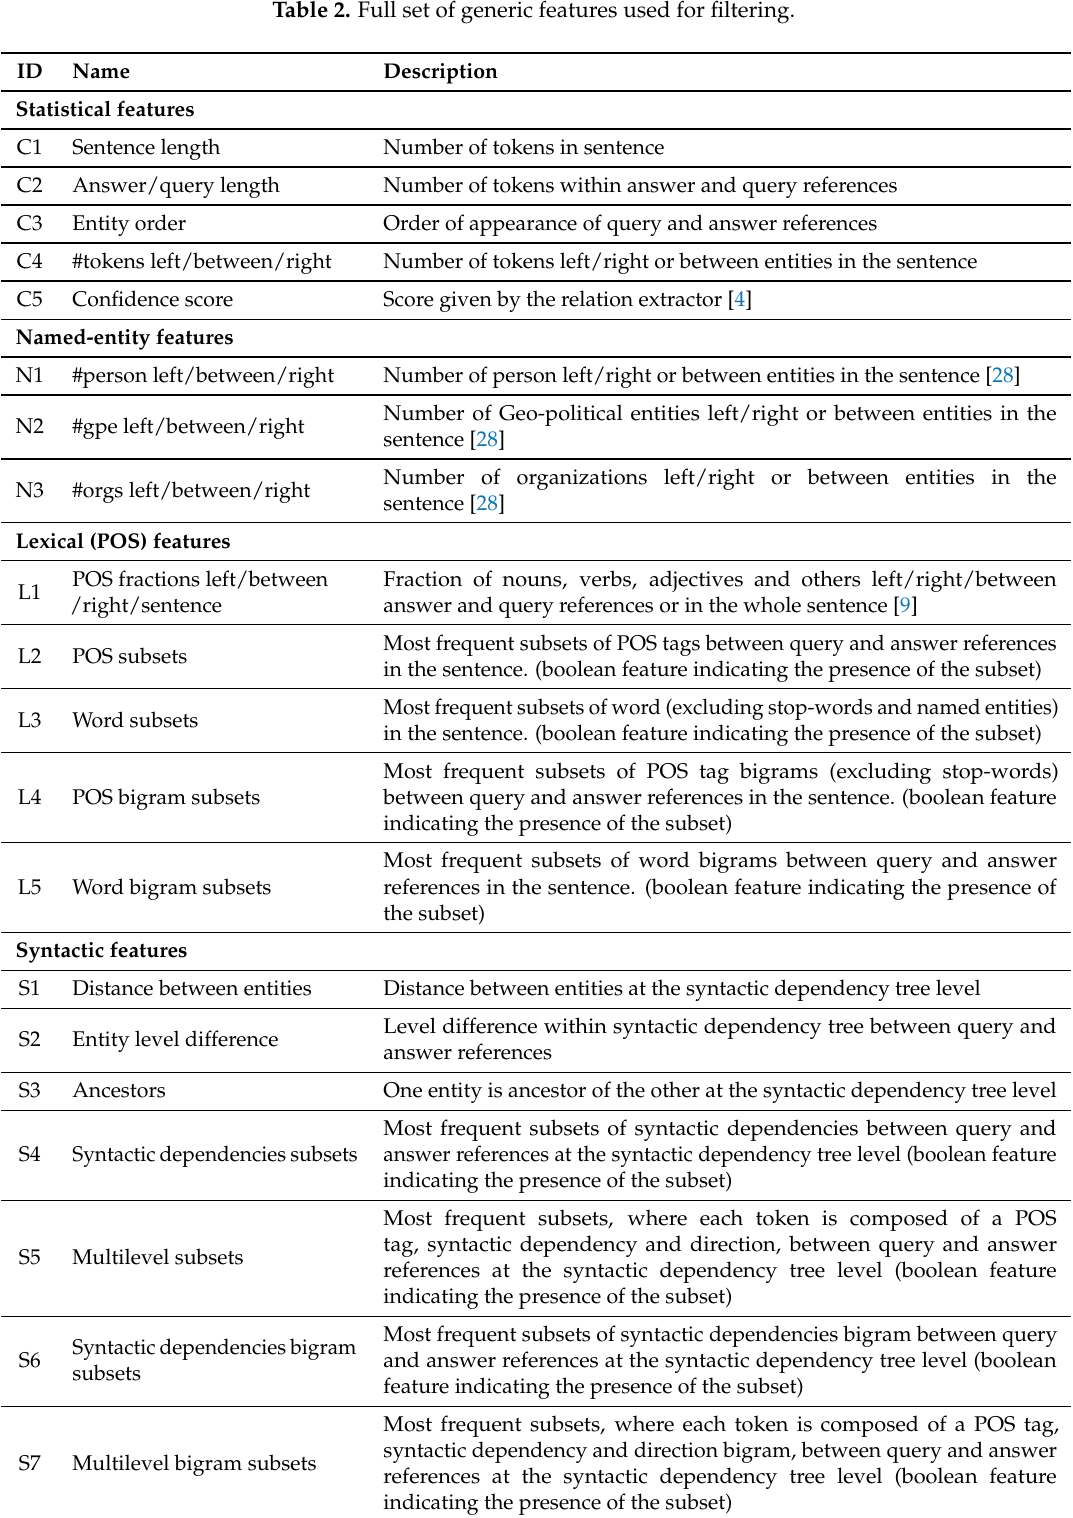
Table 2. Full set of generic features used for